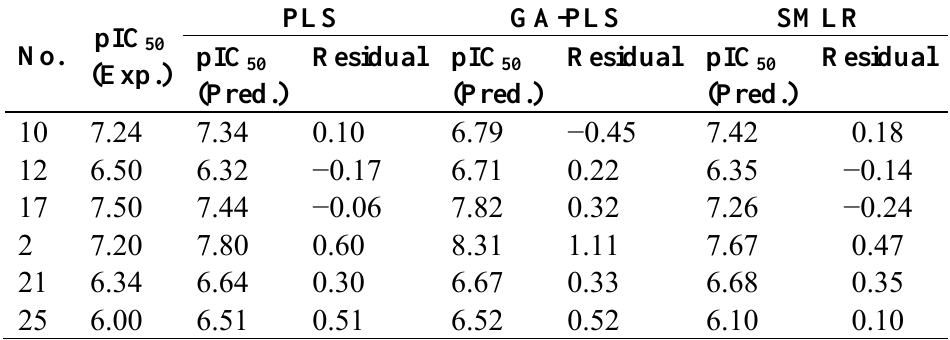
Table 12. Comparison of Experimental and predicted values of pIC SMLR, PLS and GA-PLS